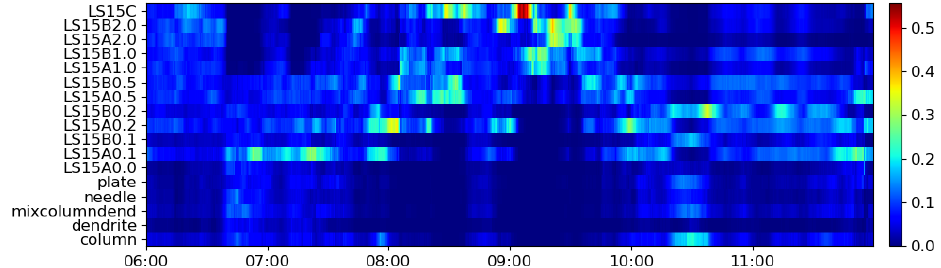
Figure 10. The contribution of each snow retrieval to the final PSD estimate. The weights depend on the distance between the simulated and the measured Doppler spectra above the freezing